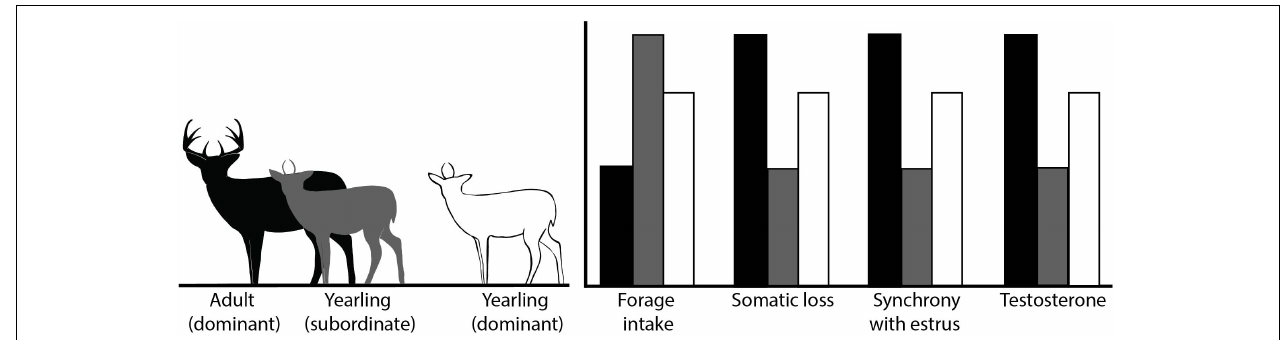
FIGURE 1 | Conceptual illustration of the associated predicted outcomes of variables of interest, which included forage intake, somatic loss (e.g., body mass and body fat), degree of synchrony of reproductive effort with estrus in females, and hormone levels for our study evaluating reproductive effort in male white-tailed deer. Treatment groups included subordinate yearlings (1.5-years old) which were maintained in the presence of adult males ( ≥ 4.5-years old), and dominant yearlings maintained without adult males, Brookings, SD, United States.